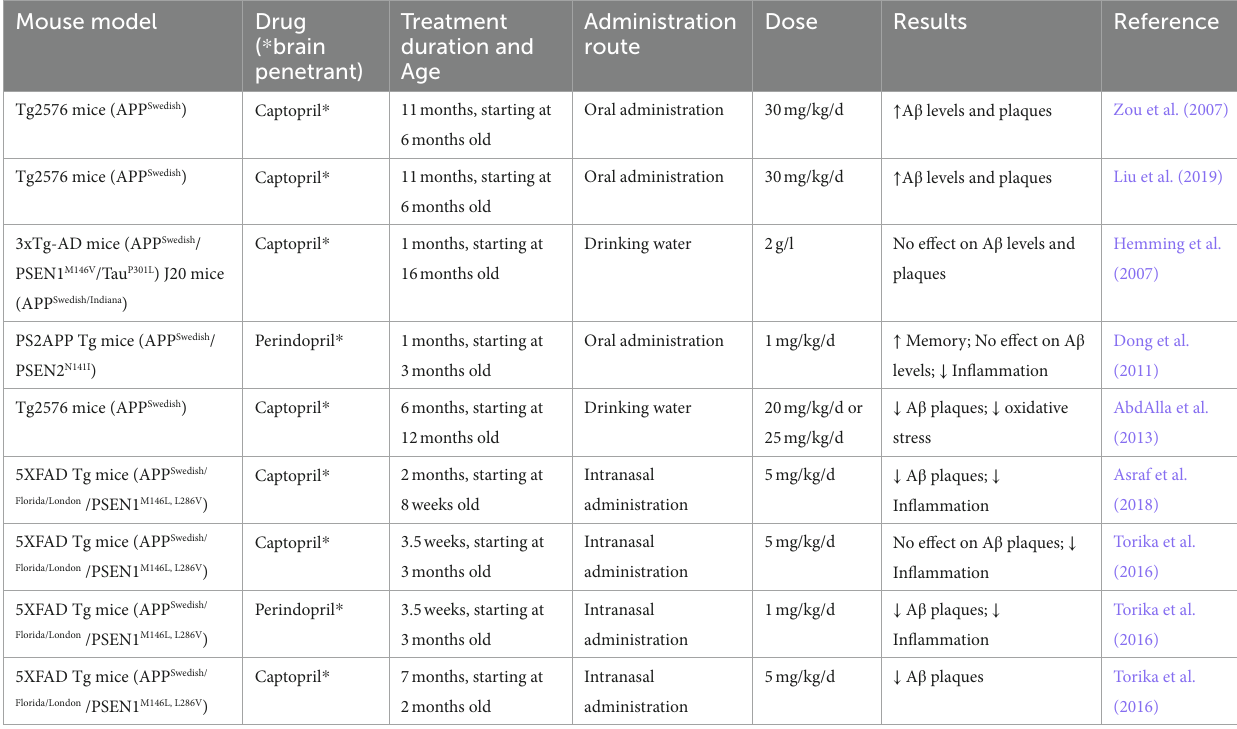
TABLE 2 Summary of effects of ACE-Is in mouse models of AD including A β levels and deposition, neuroinflammation and oxidative stress and, cognitive deficits. Mouse model